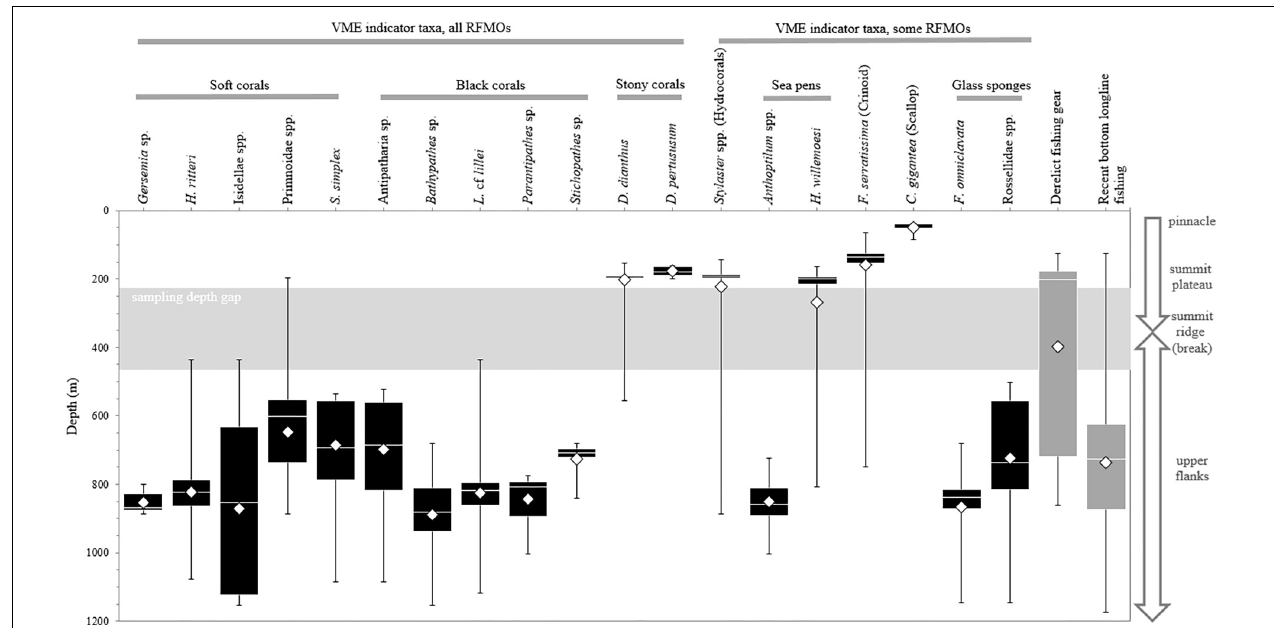
FIGURE 6 | Depth ranges of 19 groupings of habitat-forming biological structures and derelict fishing gear (DFG) on Cobb Seamount, observed during the 2012 visual survey, as well as the recent longline fishing effort. The listed taxa are vulnerable marine ecosystem (VME) indicators according to one or more regional fisheries management organizations (RFMOs; see Table 1 ). Boxes represent the 1st and 3rd quartile intervals, the white band represents the median (2nd quartile), the whiskers represent the minimum and maximum, and the diamonds represent the mean. There was a survey sampling depth gap between 225 and 465 m (shaded